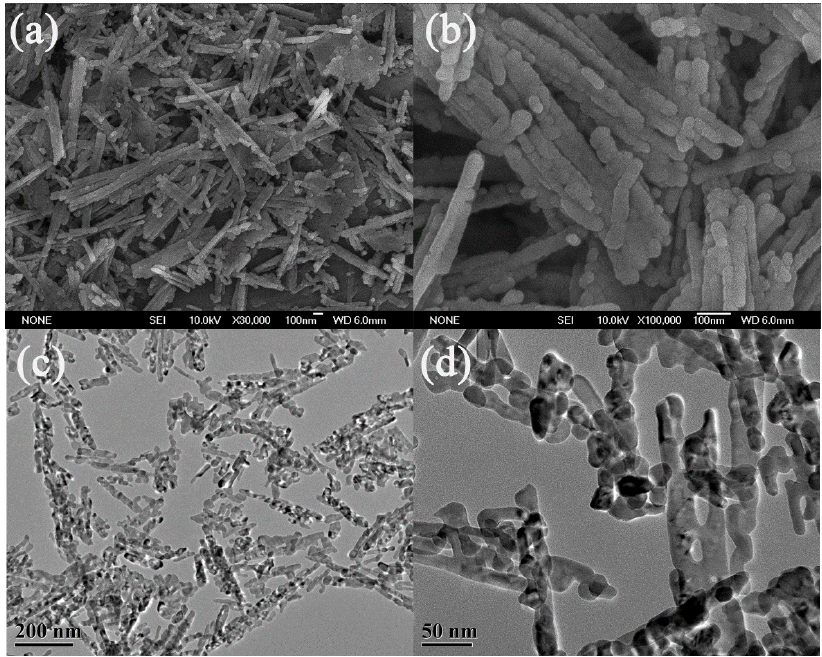
Figure 2. ( a , b ) Scanning electron microscopy (SEM) and ( c , d ) transmission electron microscopy (TEM) images of the as-prepared Co 3 O 4